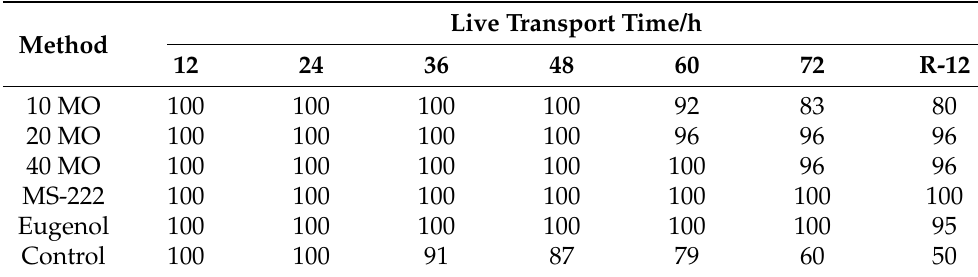
Table 1. Determination of the survival rates (%) of sea bass in different treatment groups during long-distance live